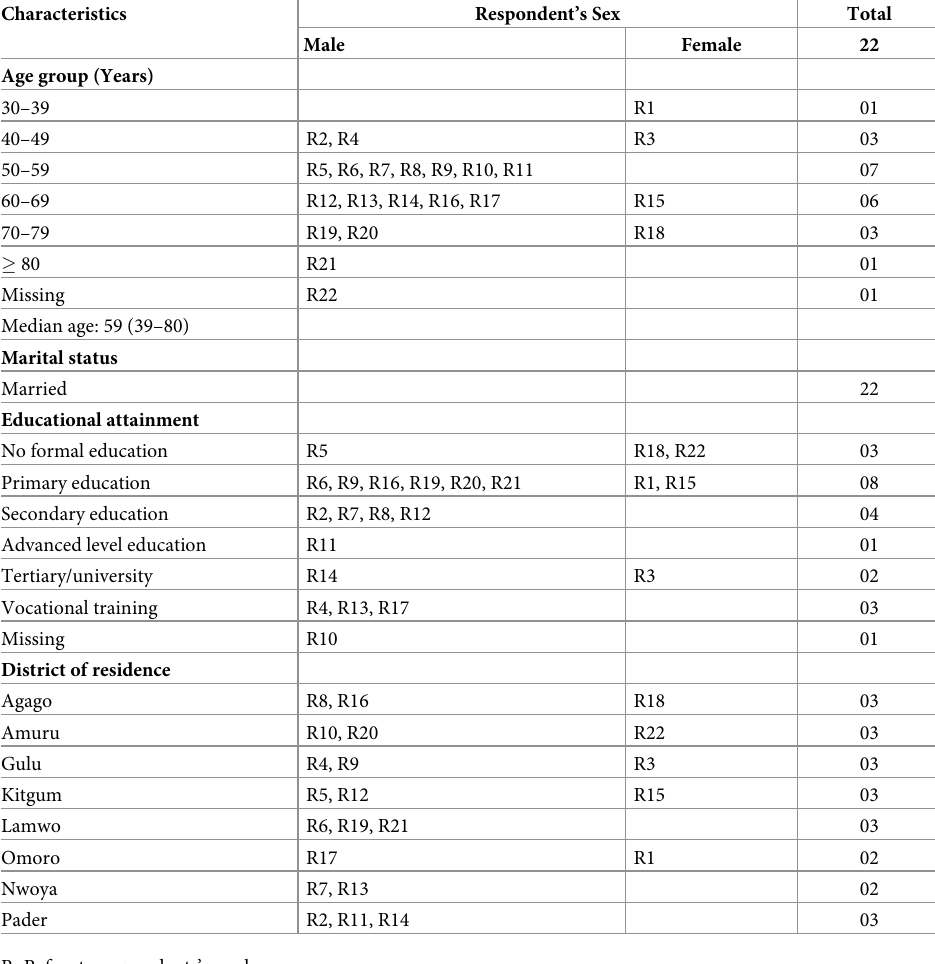
Table 1. Respondents’